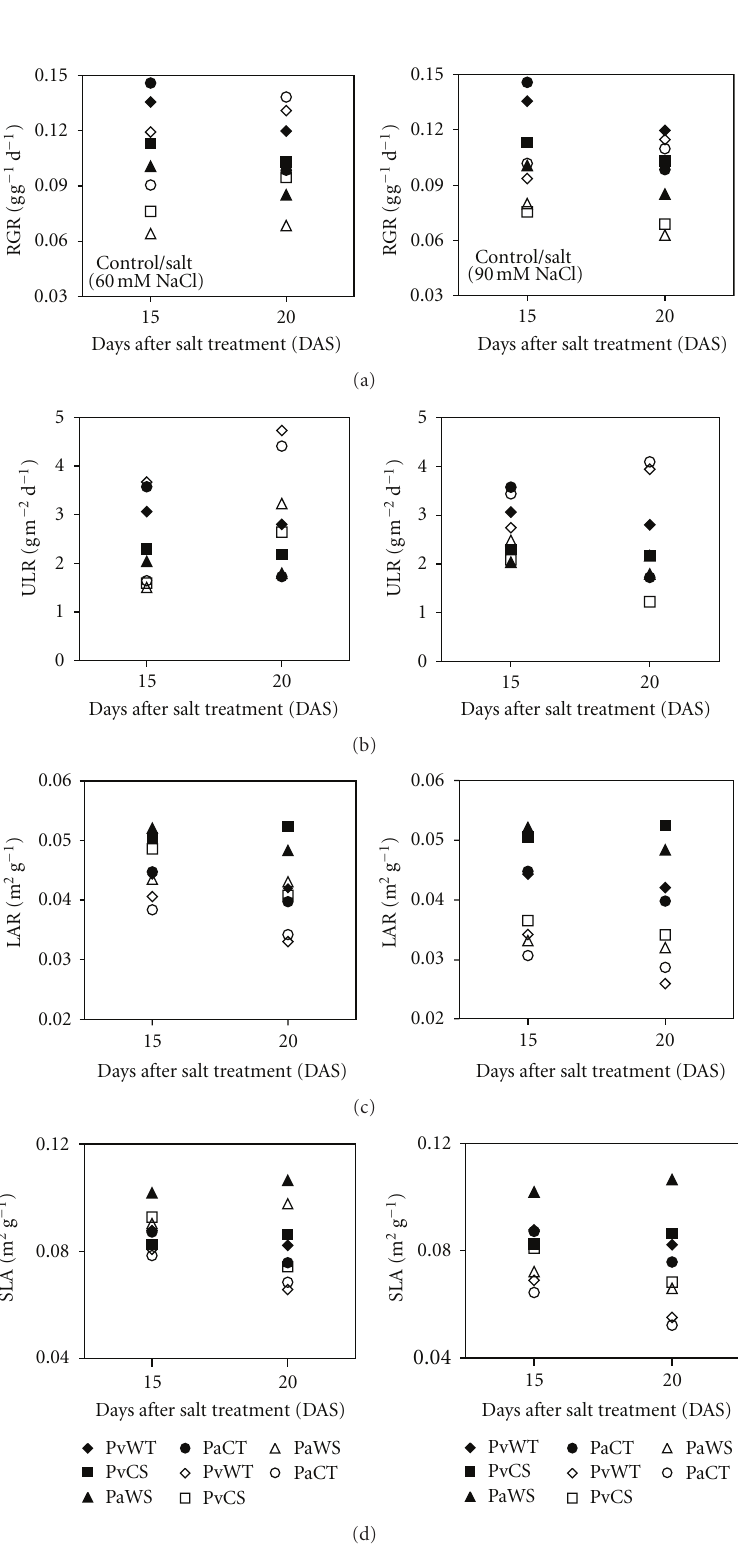
Figure 2: E ff ects of increasing NaCl levels on relative growth rate (RGR) (a), unit leaf rate (ULR) (b), leaf area ratio (LAR) (c), and specific leaf area (SLA) (d) for Phaseolus species, based on the di ff erences between two means (10–15 and 15–20 days). Each value represents the mean ± SE of six replicates. Control (filled symbols) and salt treatments open